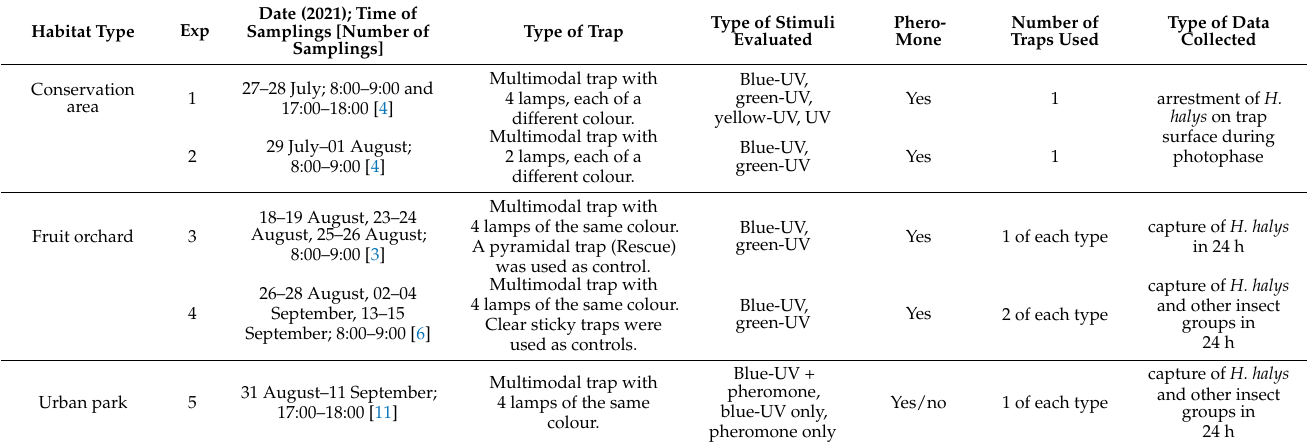
Table 1. Overview of the different field experiments